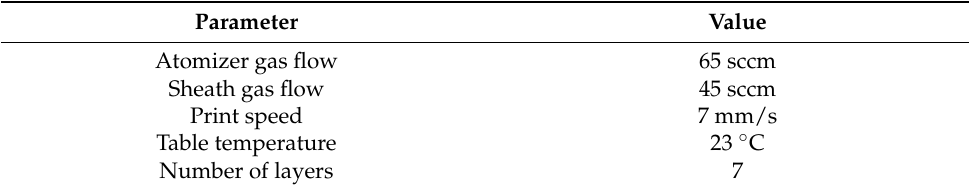
Table 3. Printing parameters for the Optomec 300 series.